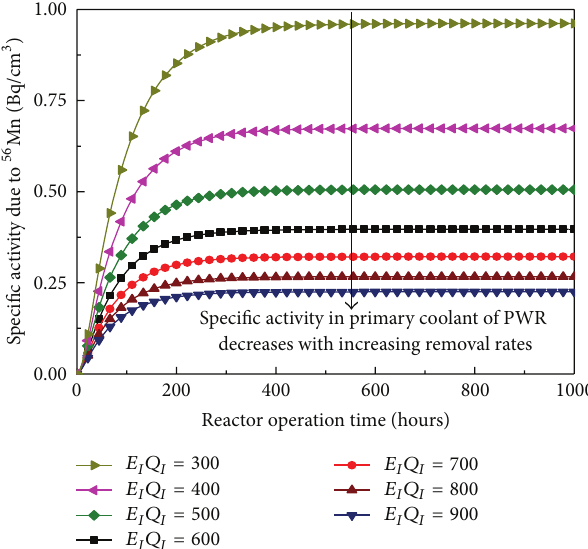
Figure 1: Variation of specific activity in primary coolant of PWR with different values of ion-exchanger removal